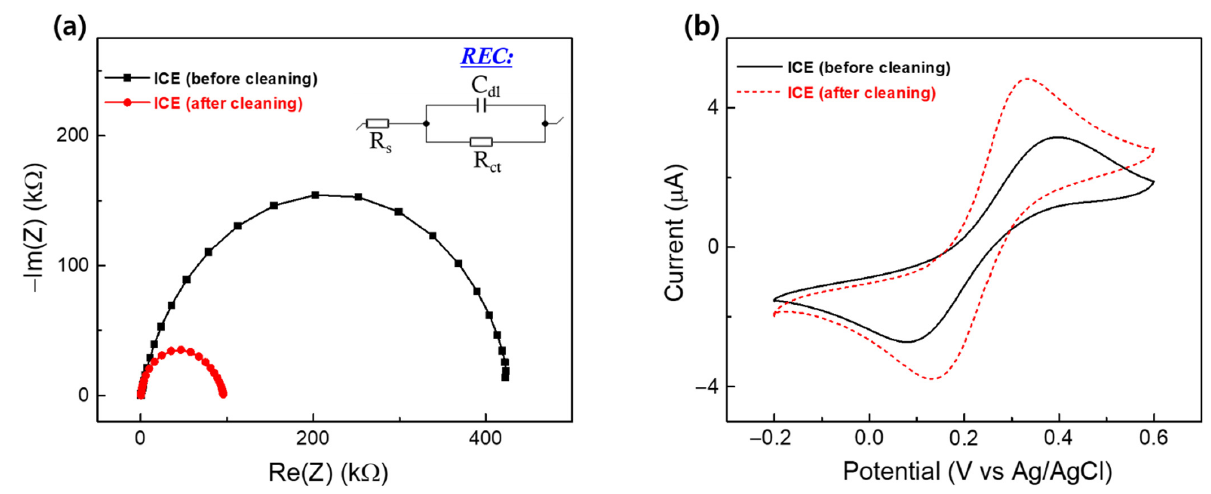
Figure 2. ( a ) EIS and ( b ) CV results of ICE, before and after the cleaning